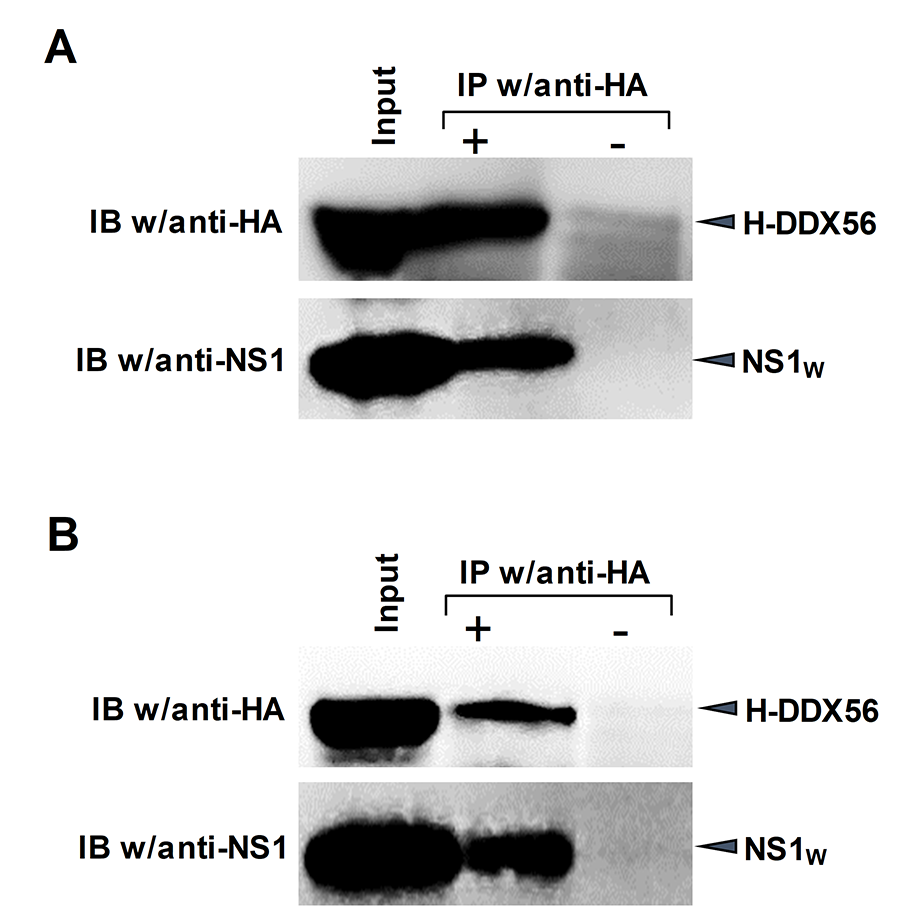
Figure 2 – The immunoprecipitation analysis of human DDX56 and influenza A virus NS1 protein interaction in mammalian cells. The cells were co-transfected with pCHA-DDX56 plasmid and pCAGGS-NS1 ( A ) or transfected with pCHA-DDX56 plasmid and infected with influenza A (WSN) w viruses ( B ). The cell lysates were prepared, and H-DDX56 proteins were precipitated with mouse monoclonal anti-HA antibody as described in the methods section. For blotting rabbit polyclonal anti-NS1 and mouse monoclonal anti-HA antibody were